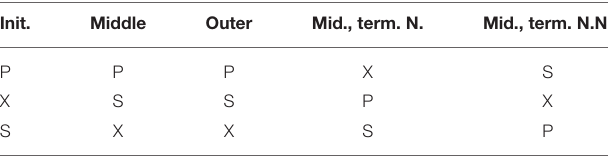
TABLE 1 | Result of standard permutation between each pair of sites within two contacts. Init. Middle Outer Mid., term. N. Mid., term. N.N.